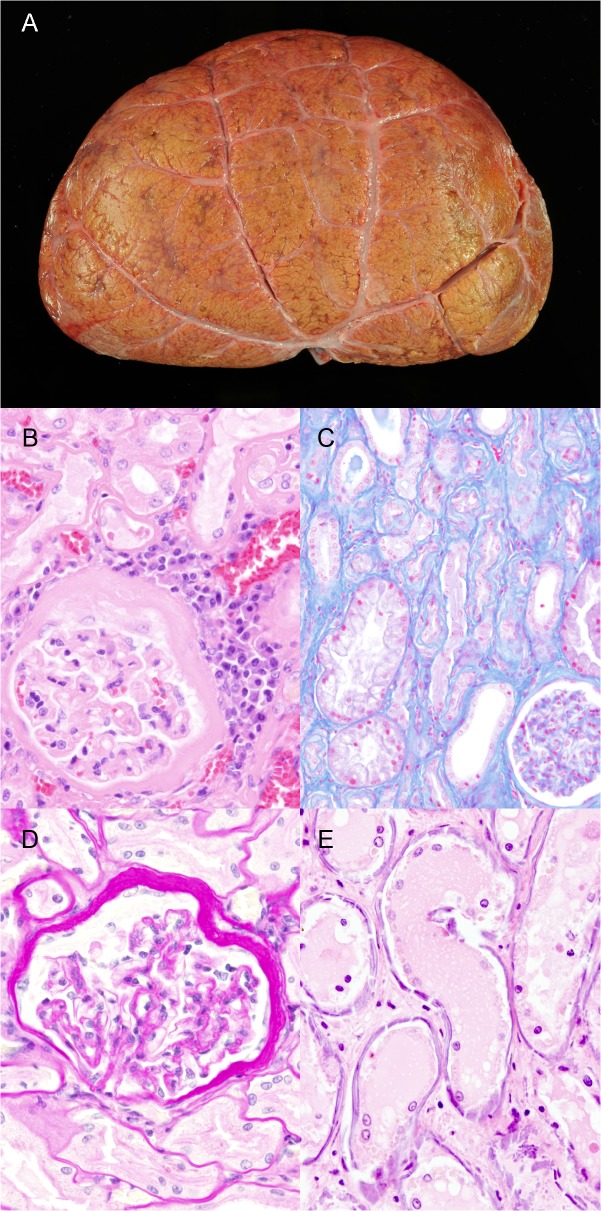
Renal lesions in wild felids A) Kidney, tiger, 19 years, male (animal no. 27).Chronic interstitial nephritis with an irregular surface of the kidney. B) Kidney, cougar, 18 years, female (animal no. 4). Membranous glomerulonephritis with moderate to severe thickening of Bowman’s capsule. Interstitial infiltrations consisting of lymphocytes, plasma cells and fewer macrophages. H&E-staining. C) Kidney, lion, 6 years, female (animal no. 18). Moderate diffuse interstitial fibrosis. Azan staining. D) Kidney, cougar, 18 years, female (animal no. 4). Membranous glomerulonephritis and a moderate, diffuse thickening of Bowman’s capsule are present. Periodic Acid-Schiff reaction. E) Kidney, tiger, 1 year, female (animal no. 33). Tubular basement membranes displaying severe diffuse depositions of basophilic, plaque-like extracellular material (mineralization). H&E-staining.